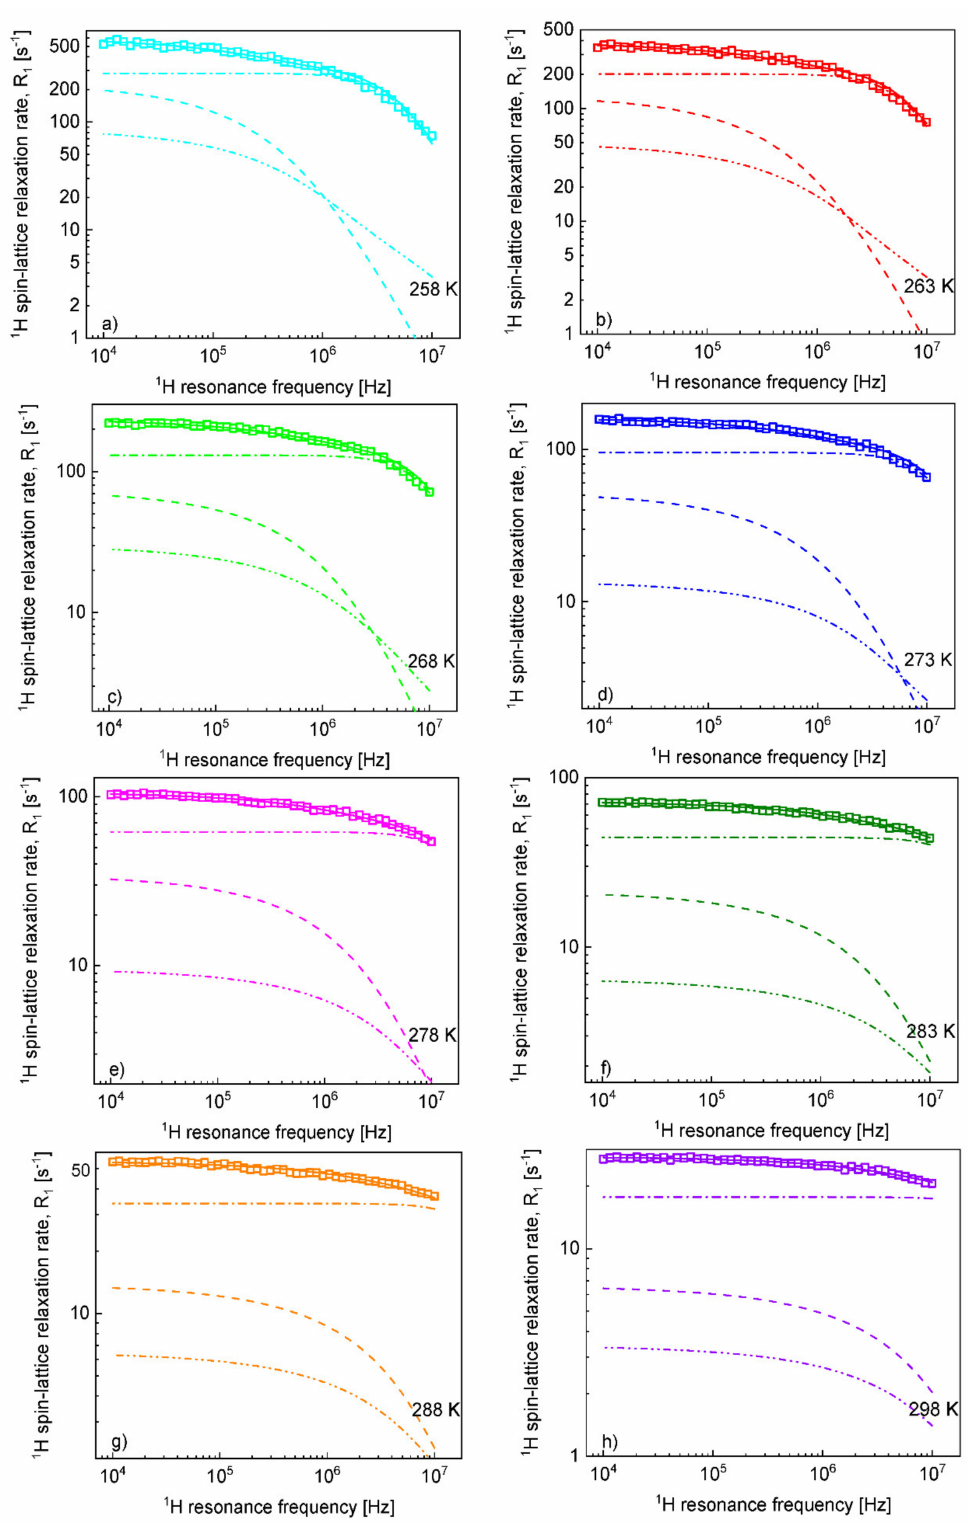
Figure 4. 1 H spin-lattice relaxation rates, R 1, H ( ω H ) , for [TEA-C4][TFSI]; solid lines—theoretical fits decomposed into ( ω ) (dashed lines), R inter , HF R inter , HH H 1, H temperatures ( a – h